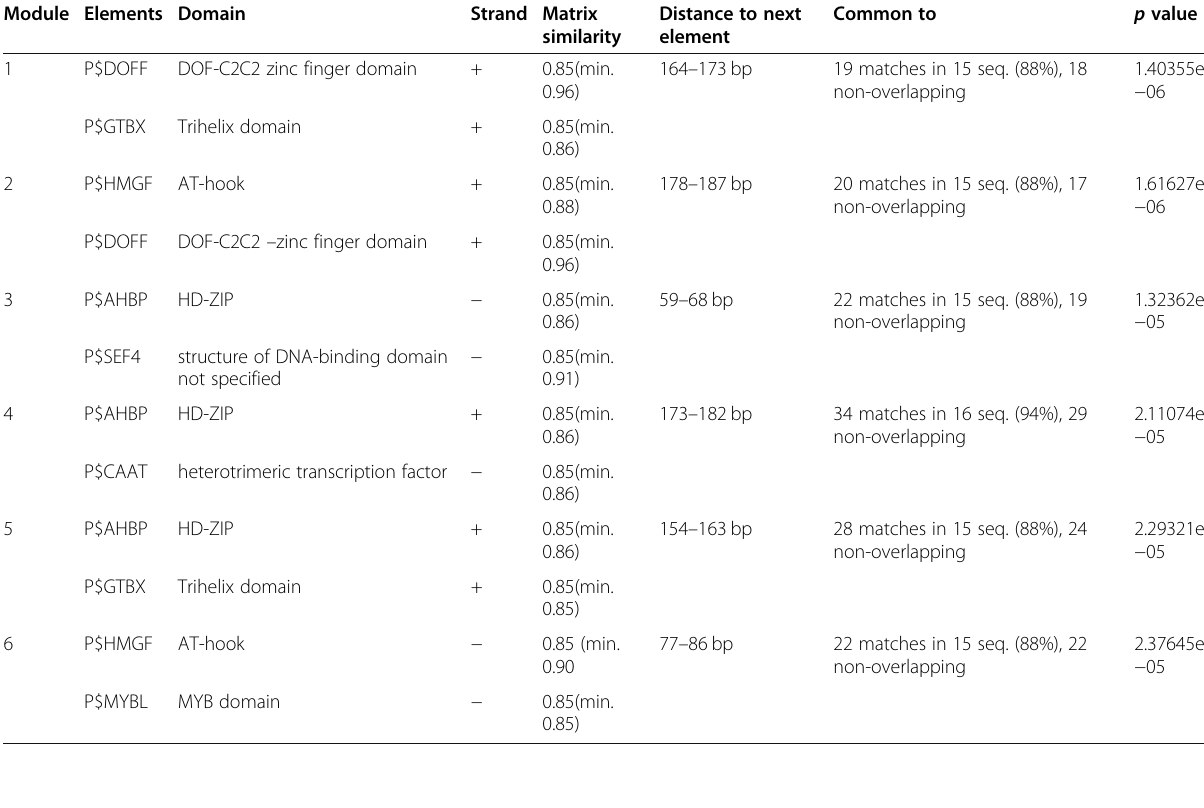
Table 3 Cooperative modules found in the promoter of the hub genes